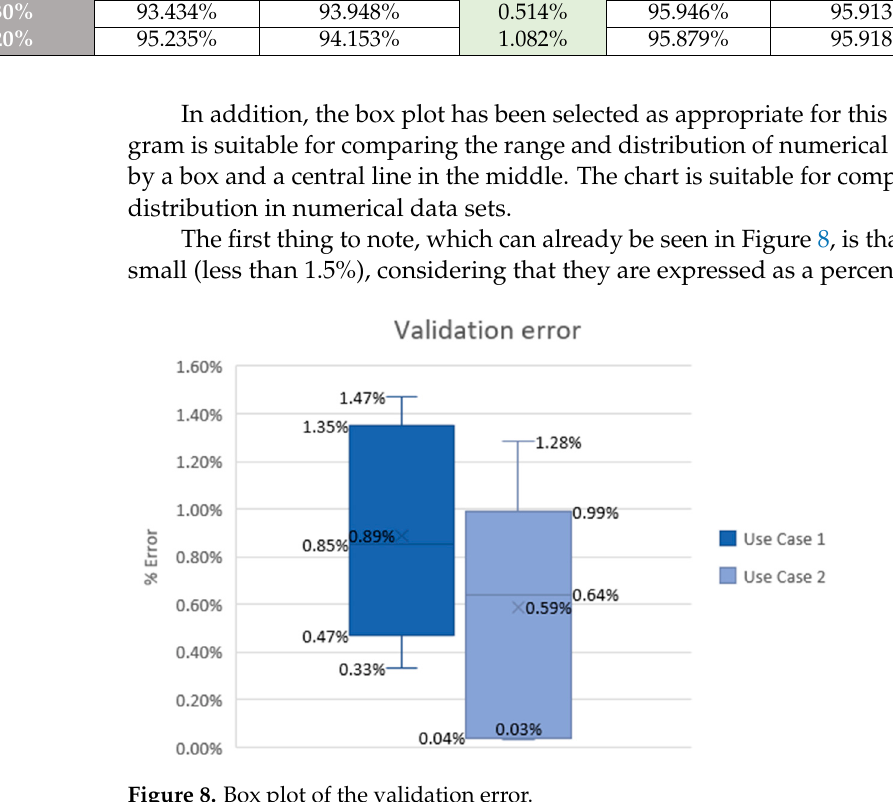
Figure 8. Box plot of the validation error .